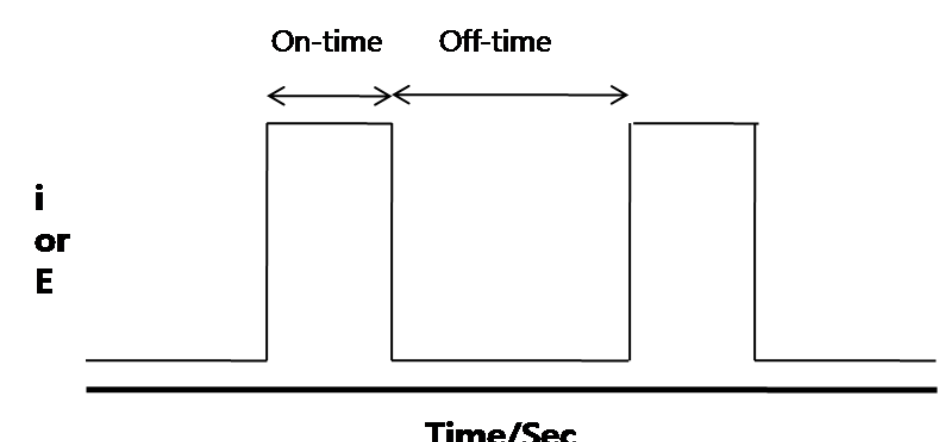
Figure 1. Schematic diagram of the electroplating system.